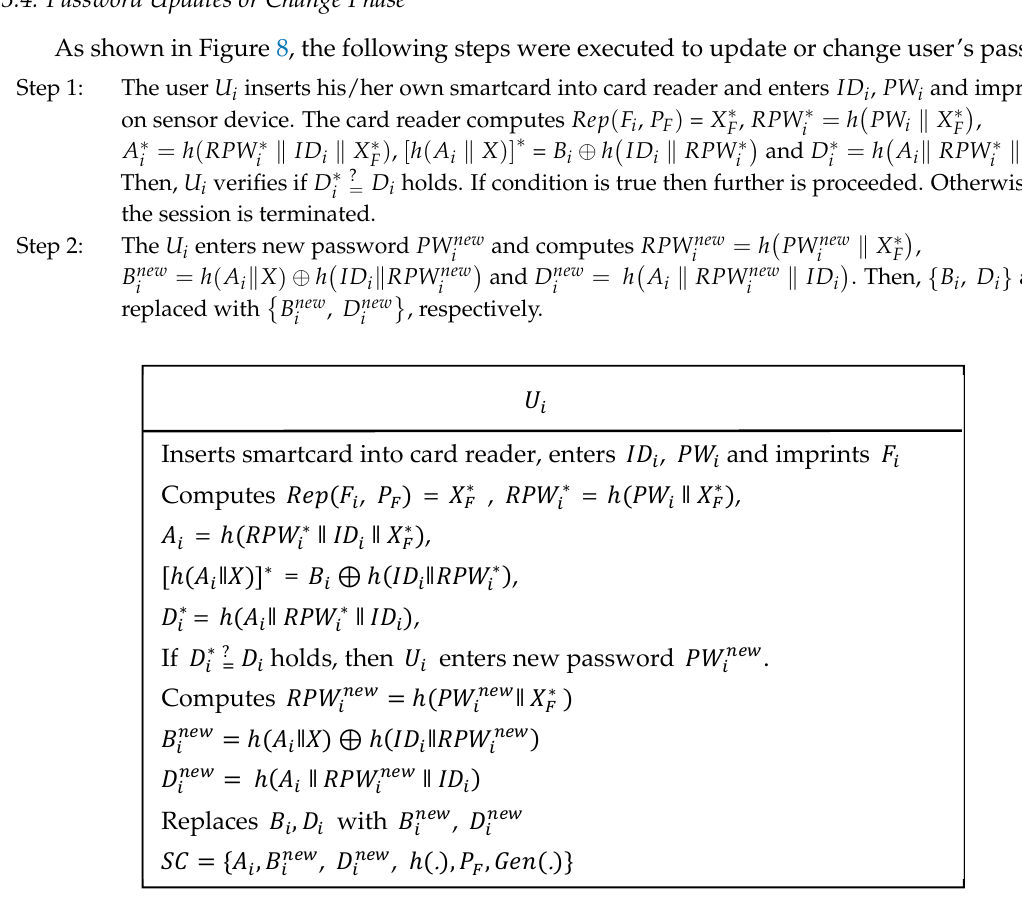
Figure 8. Password update phase of the proposed scheme.